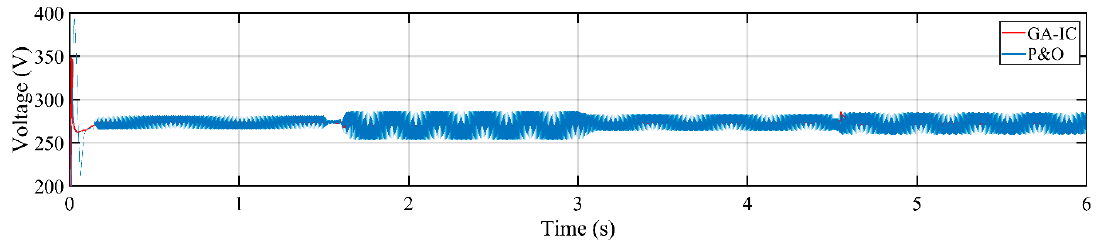
Figure 18. Case 1 voltage comparison of modified GA-IC vs. P&O.